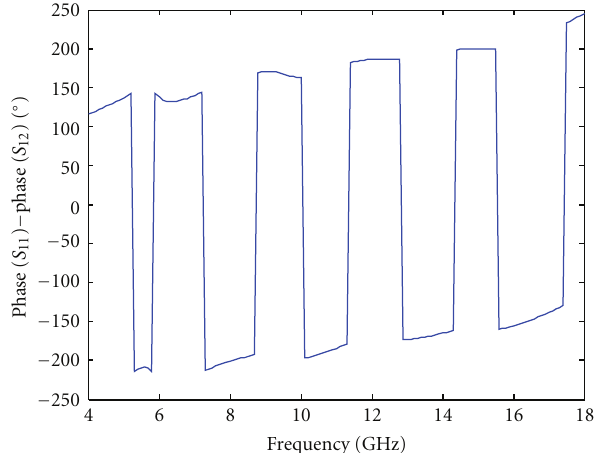
Figure 14: The phase di ff erence between S 11 and S 12 with R = 0 . 3mm − 1 .